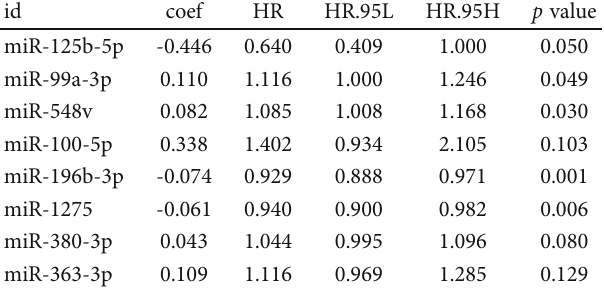
GC samples = 111 ) datasets used in the validation phase were downloaded from the Gene Expression Omnibus